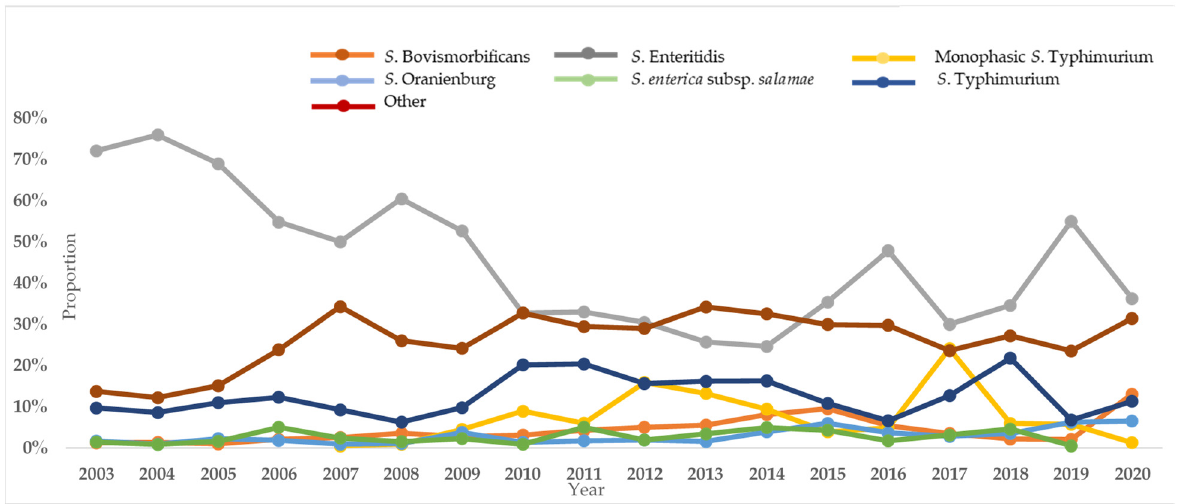
Figure 1. The proportion (%) of S. Enteritidis, S . Typhimurium, Monophasic S. Typhimurium, S. Bovismorbificans, S. Oranienburg, S. enterica. subsp. salamae and of all other serotypes by year, Greece, 2003–2020.